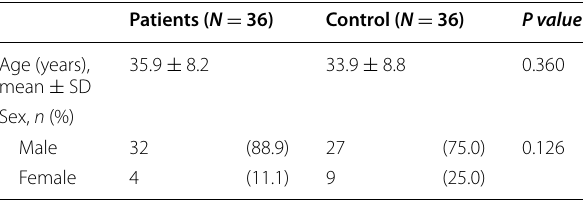
Table 1 Comparison between studied groups as regards